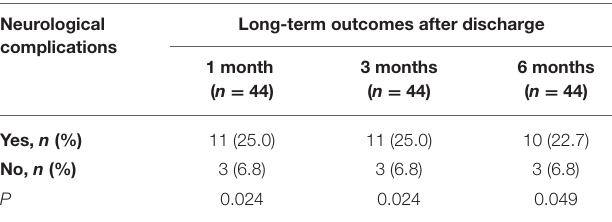
TABLE 5 | Effect of neurological complications on long-term neurological outcomes. Neurological